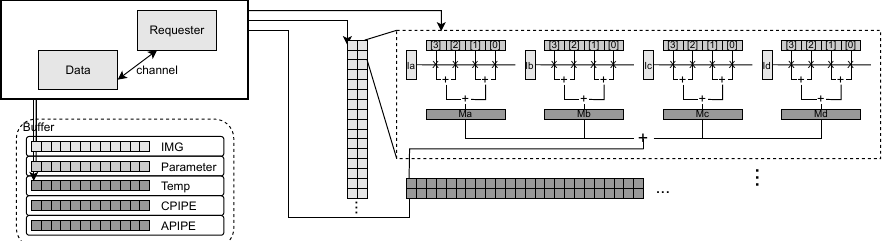
Figure 5. The internal structure for convolution processing of PE in CPIPE